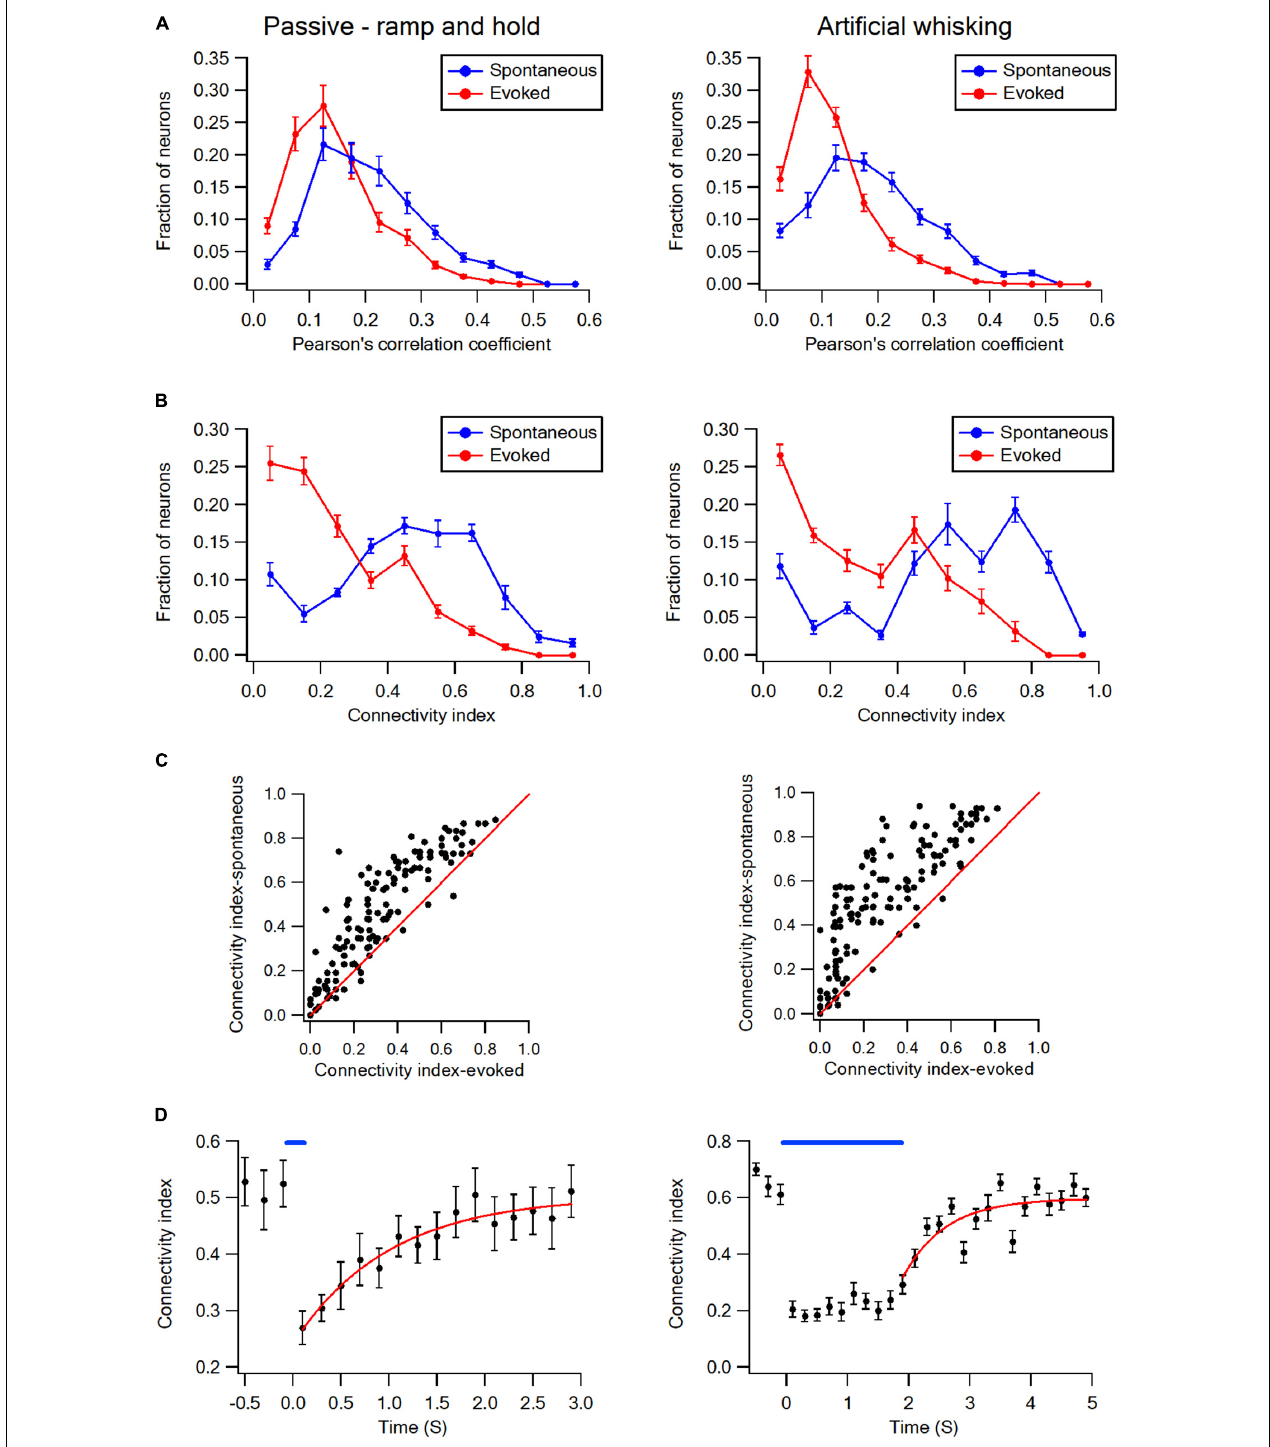
FIGURE 2 | Desynchronization histograms and dynamics in wS1 barrel cortex. (A) Histograms showing the averaged fraction of wS1 neurons ( M ± SEM ) with different Pearson’s correlation coefficient values during ramp-and-hold (left) and artificial whisking (right) paradigms. Note the leftward shift of the curves during evoked activities. Comparison of the spontaneous and evoked histograms during both the passive ramp-and-hold and artificial whisking yielded p < 0.001 using the X 2 statistical test. (B) Histograms showing the averaged fraction of wS1 neurons ( M ± SEM ) with different connectivity index during ramp-and-hold (left) and artificial whisking (right) paradigms. Note the leftward shift of the curves during evoked activities. Similarly, a leftward shift during the evoked state is observed ( n = 213 units